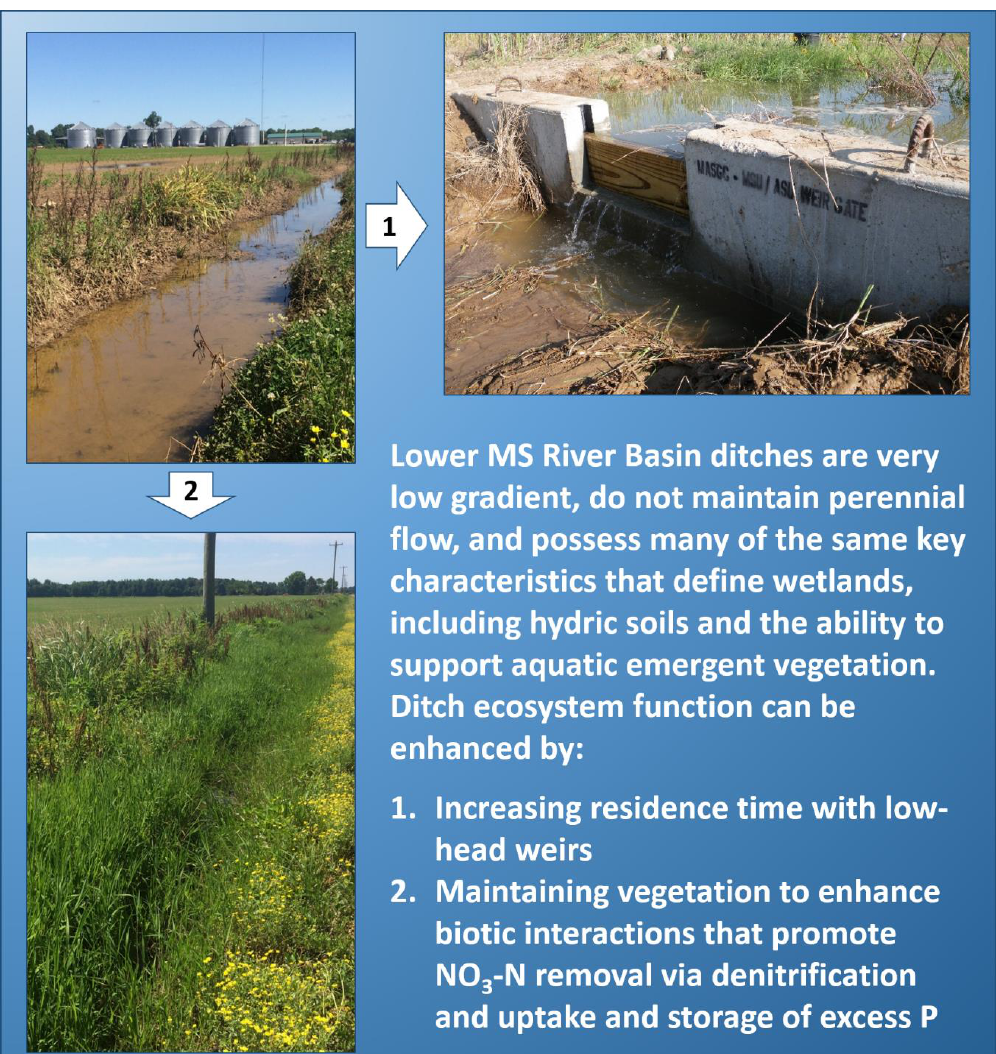
Figure 5. Enhancing effectiveness of vegetated ditches through integrated best management